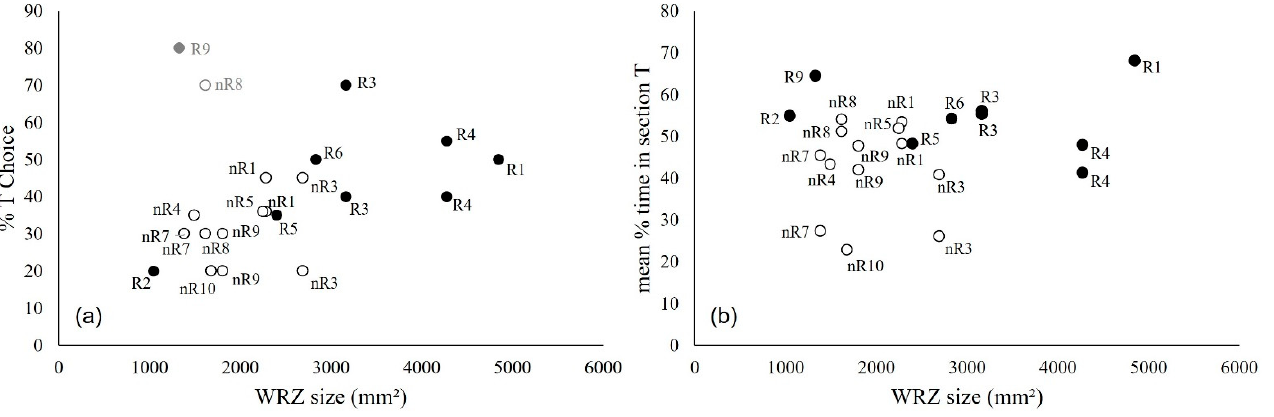
Figure 7. ( a ) Proportion of T choices (% T choice) and ( b ) mean % time in section T for all “T and C” experiments in relation to the mean area of hypersensitive wound reaction zones (lesion size, mm 2 ) in response to the inoculation of Grosmannia penicillata ; in ( a ), outlier data points of R9 and nR8 are indicated in grey; nR trees: white circles; R trees: black circles; study trees tested against both controls, C1 and C2, are represented twice in the figures.